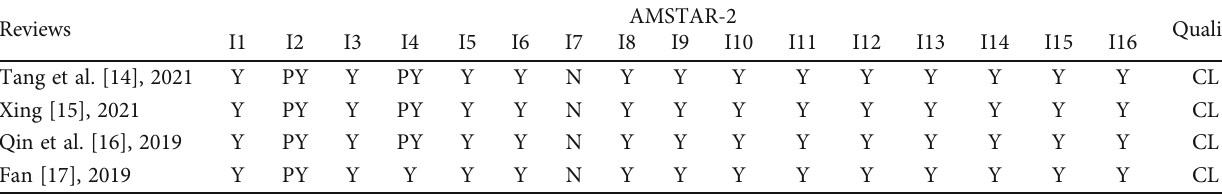
Table 3: Result of the AMSTAR-2